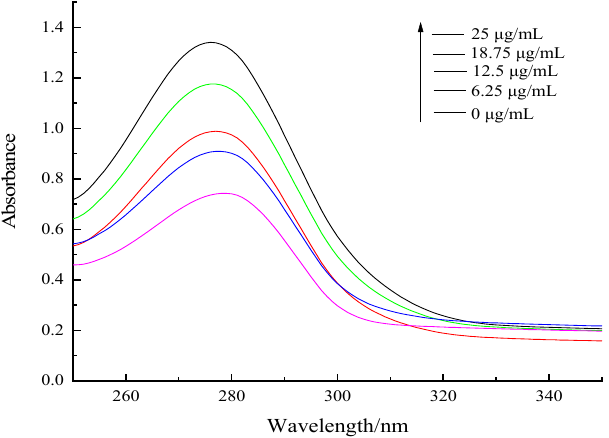
Figure 2. UV–vis spectrum of different concentrations of catechins binding to IgY.